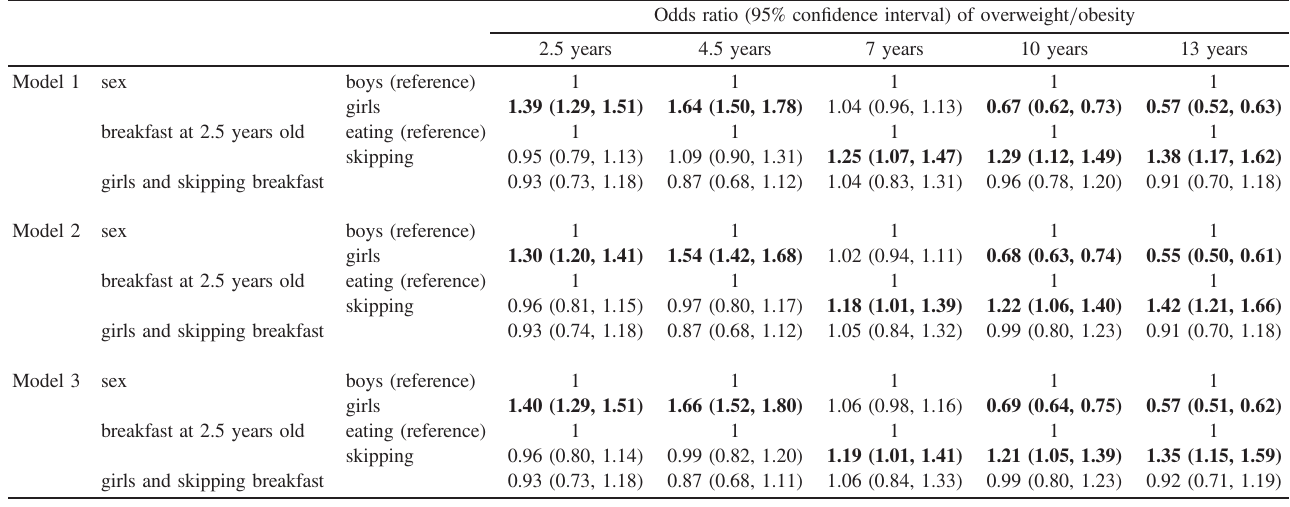
Table 5. Multivariable adjusted odds ratios of overweight / obesity for sex and skipping breakfast at 2.5 years